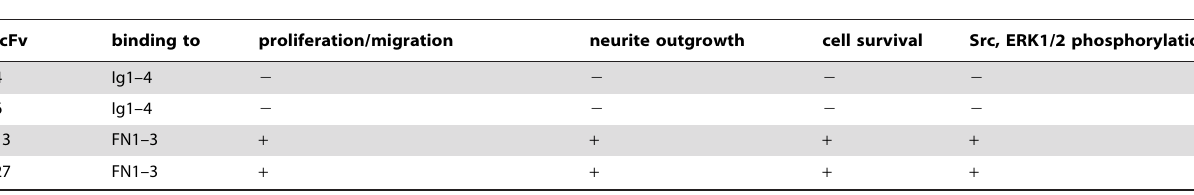
Effect: inhibition ( 2 ), stimulation ( + ).